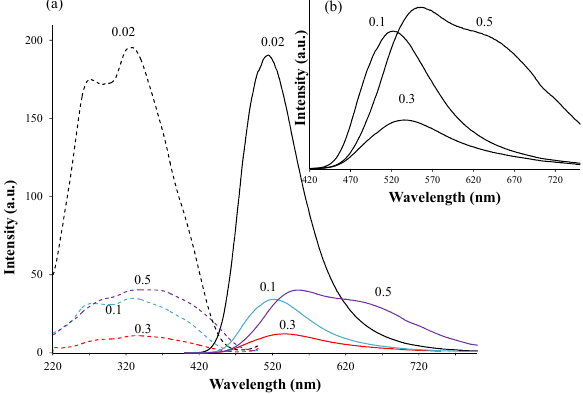
Figure 10. PL properties of (Ca 1.97– y Eu 2+ y □ 0.03 )(Si 0.94 P 0.06 )O 4 phosphors with ( y ) = 0.02, 0.1, 0.3, and 0.5. ( b ) is an enlarged part of the figure in ( a ).